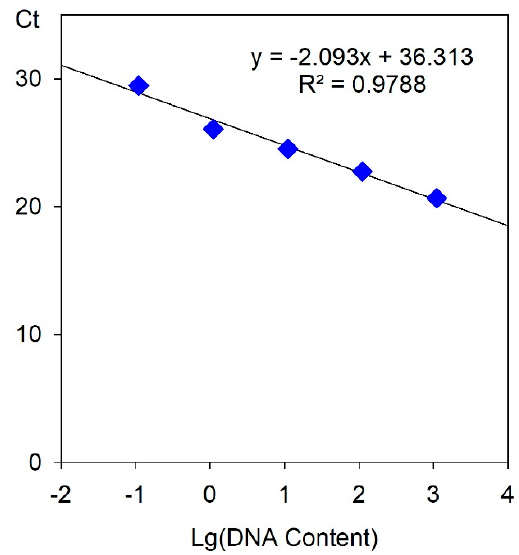
Figure 6. The standard curve between the Ct value in the qPCR reaction and the DNA contents in the reaction system.